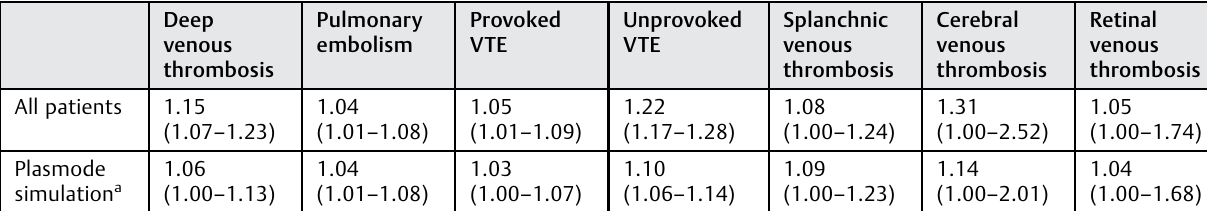
Abbreviation: VTE, venous thromboembolism (deep venous thrombosis and pulmonary embolism). a Mean peak-to-trough ratio from random reassignment of monthly deaths 1,000